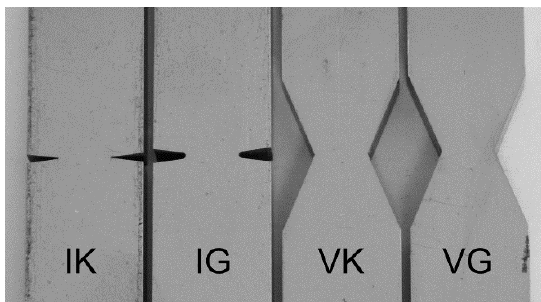
Figure 3. Specimen of test series 18–21.